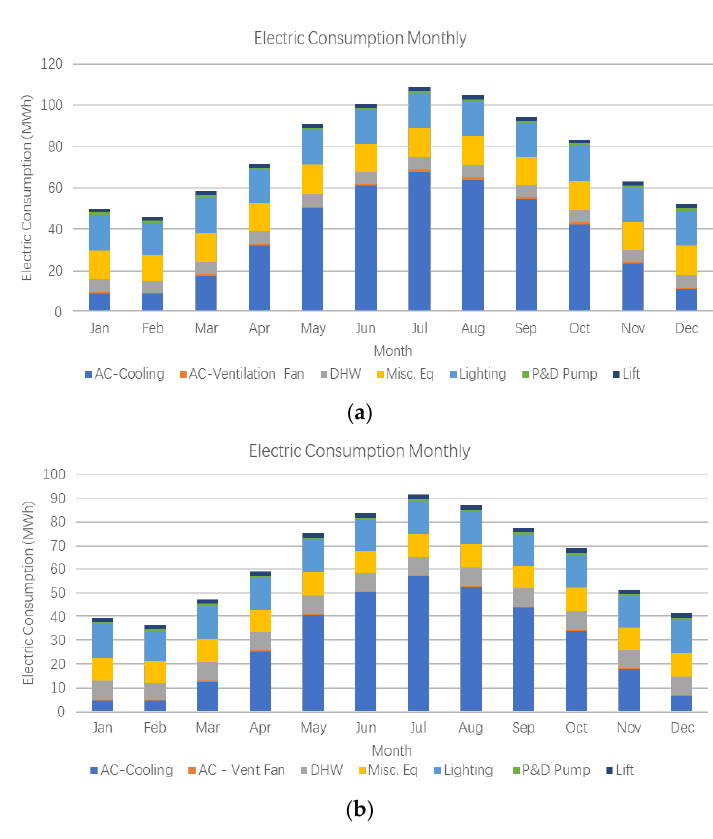
Figure 7. Monthly energy consumption for ( a ) Model 1 and ( b ) Model 2.